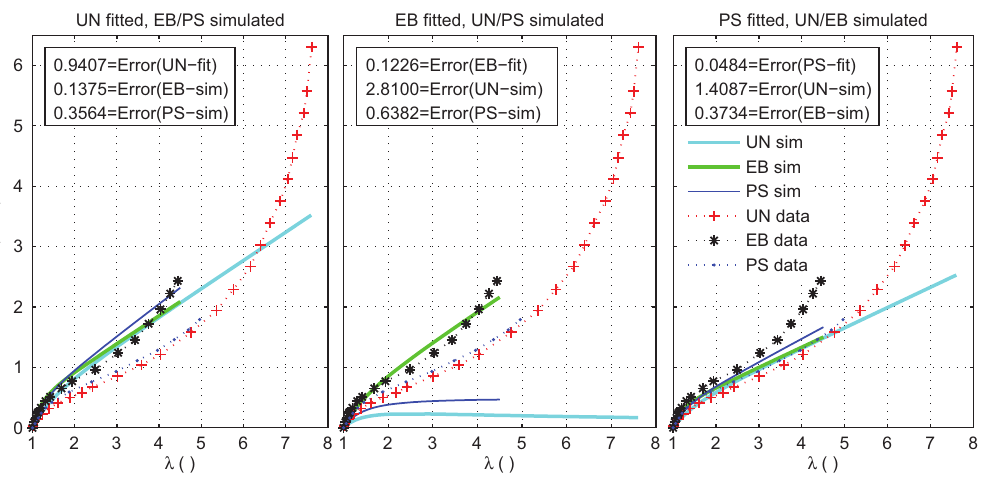
Figure 15 Performance of the tube model on the Treloar data. The fitting for the UN (left) and EB (middle) produce unacceptable results due to the inability of the model to produce the characteristic S